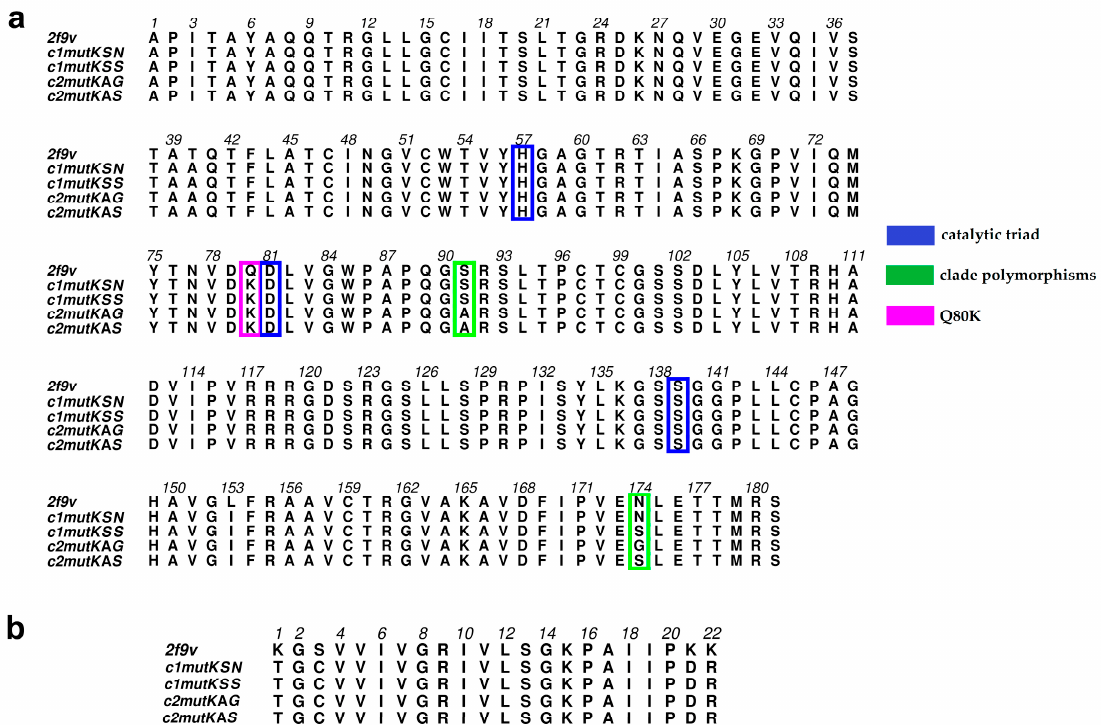
Table 1. Evaluation of HCV NS3 protein models.